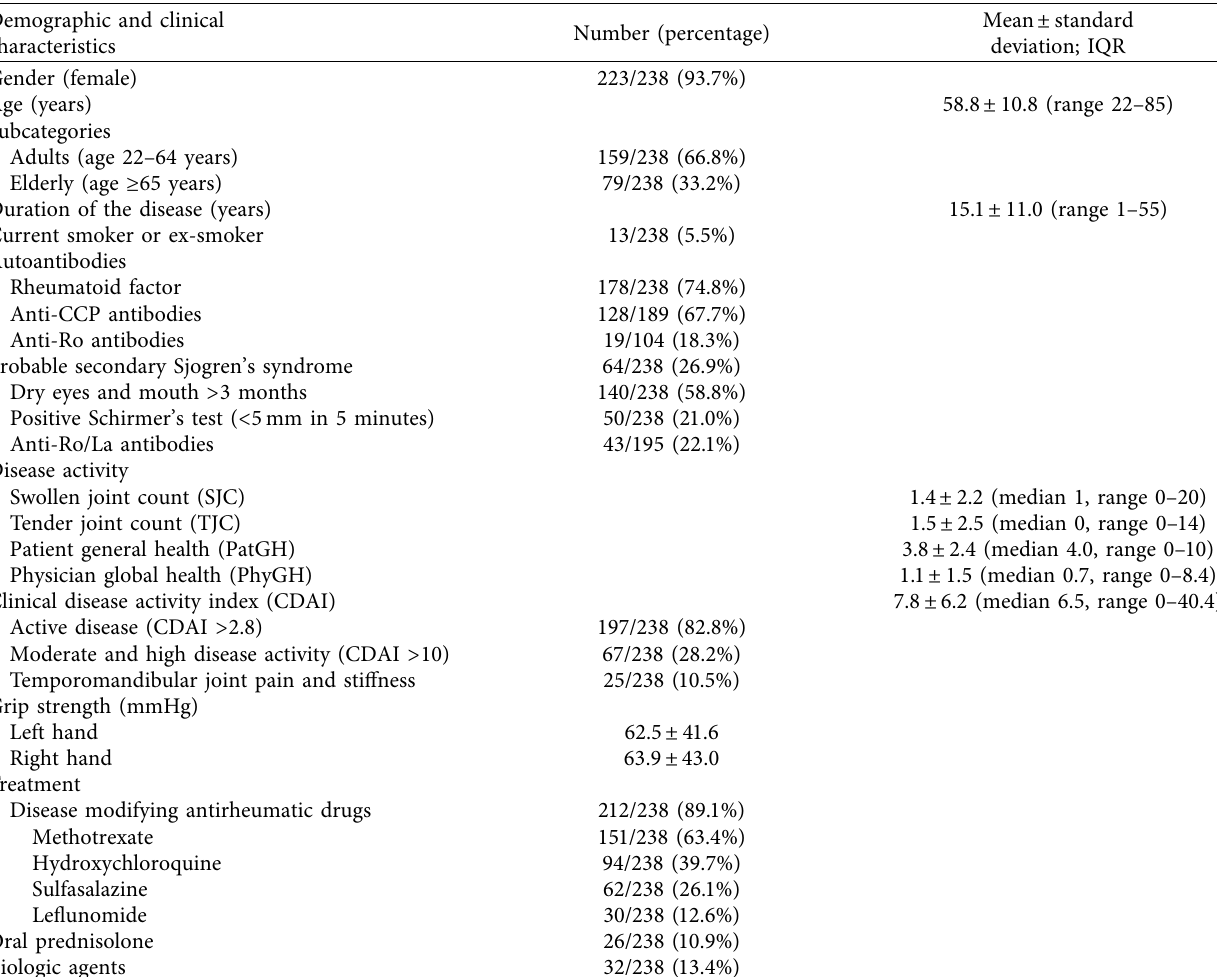
Table 1: Demographic and clinical characteristics of rheumatoid arthritis patients in this study ( n � 238). Demographic and